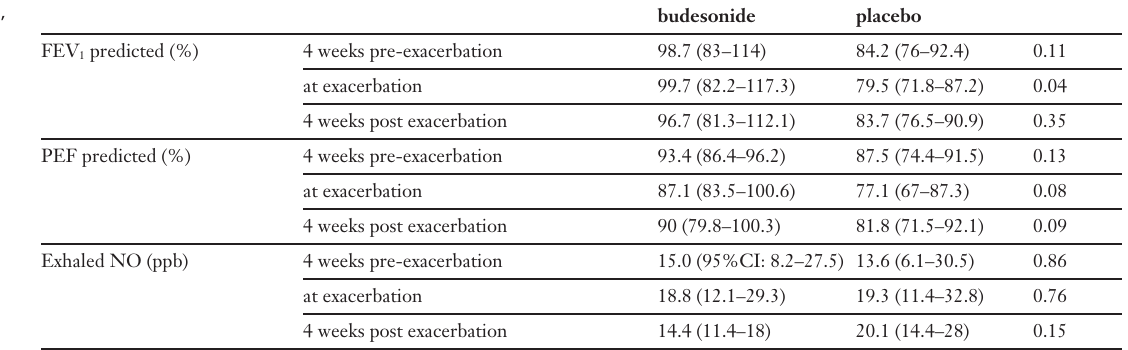
Figure 1 Weekly peak expira- tory flow % best of run-in period pre- and post exacerbation.